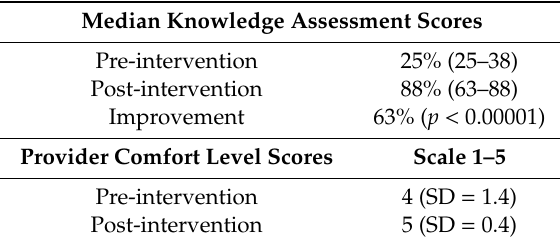
Table 2. Pre- and post-intervention assessment